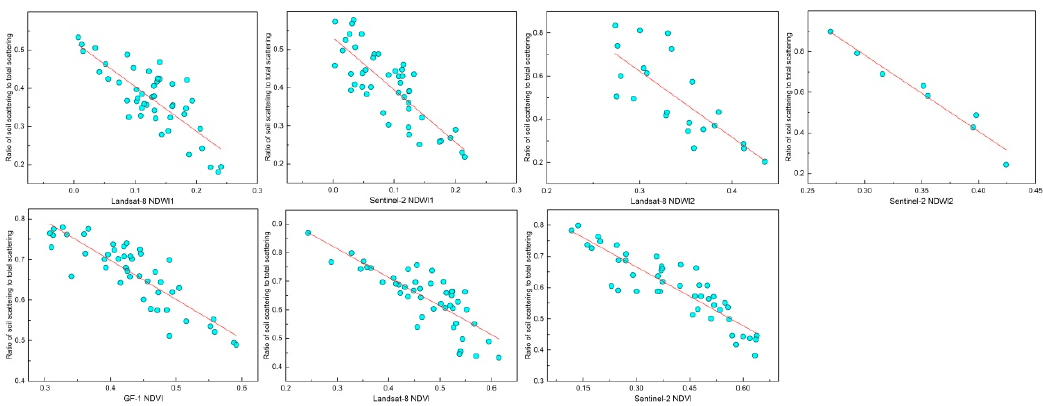
Figure 5. Ratio of bare soil contribution to total scattering ( (cid:3046)(cid:3042)(cid:3036)(cid:3039)(cid:2868) / (cid:3047)(cid:3042)(cid:3047)(cid:3028)(cid:3039)(cid:2868) ) for all sites using seven indices. Each graph fits a curve through the regression equation to show the trend.